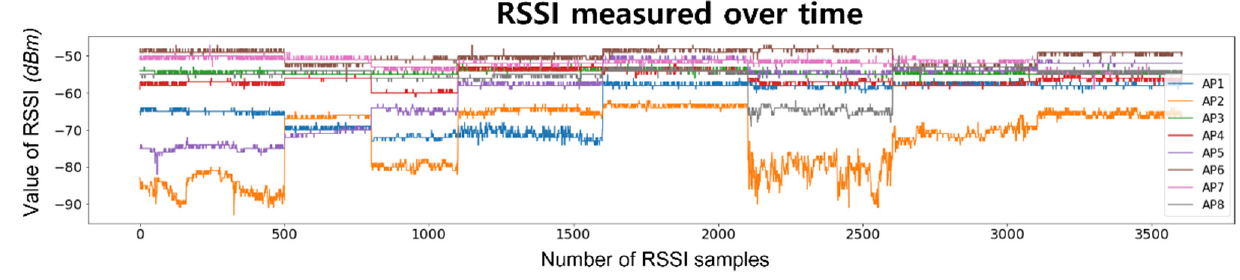
Figure 2. RSSI variation over time in the experimental environment.